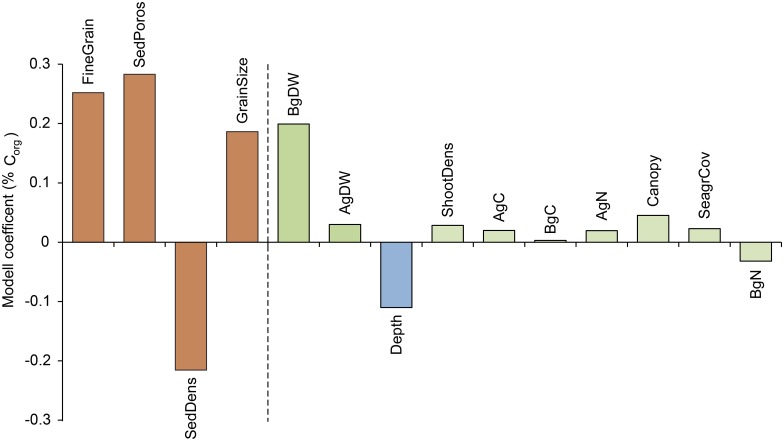
Partial least square (PLS) regression model coefficient plot.The model assesses the relative influence of different predictors on % Corg in sediment (using a mean for the top 25 cm sediment). The predictor variables are ranked in level of importance (left to right) where the four variables left of the striped bar having a VIP-value > 1 (i.e. FineGrain, SedPoros, SedDens and GrainSize) and hence significantly influencing % Corg. Brown bars = sediment characteristics, green bars = seagrass-associated variables and blue bars = water depth. Variables included in the model were FineGrain (sediment particles < 0.074 mm, %), SedPoros (sediment porosity, %), SedDens (sediment density, g DW mL-1), GrainSize (mean grain size, ɸ), Bg and Ag DW (belowground [roots and rhizomes] and aboveground [shoots] biomass dry weight, g m-2), Depth (water depth, m), ShootDens (shoot density, shoots m-2), Ag and Bg biomass C and N (biomass carbon and nitrogen content, %), Canopy (shoot height, cm) and SeagrCov (seagrass cover, %).